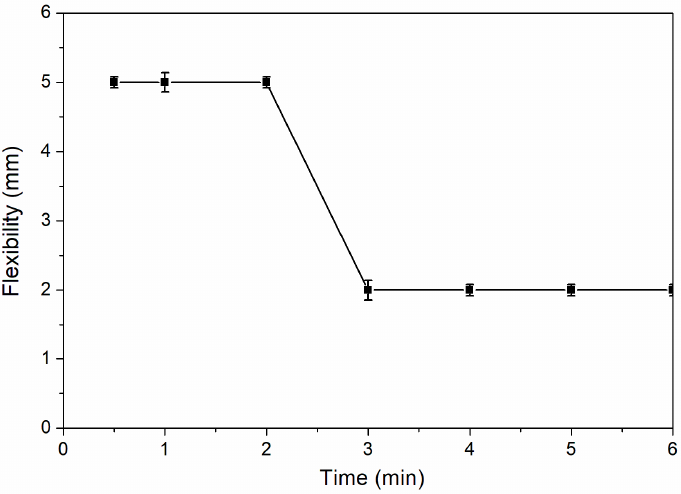
Figure 7. E ff ect of drying time on flexibility of the Figure 7. Effect of drying time on flexibility of the coating. Figure 7. Effect of drying time on flexibility of the coating. Figure 7. Effect of drying time on flexibility of the coating.